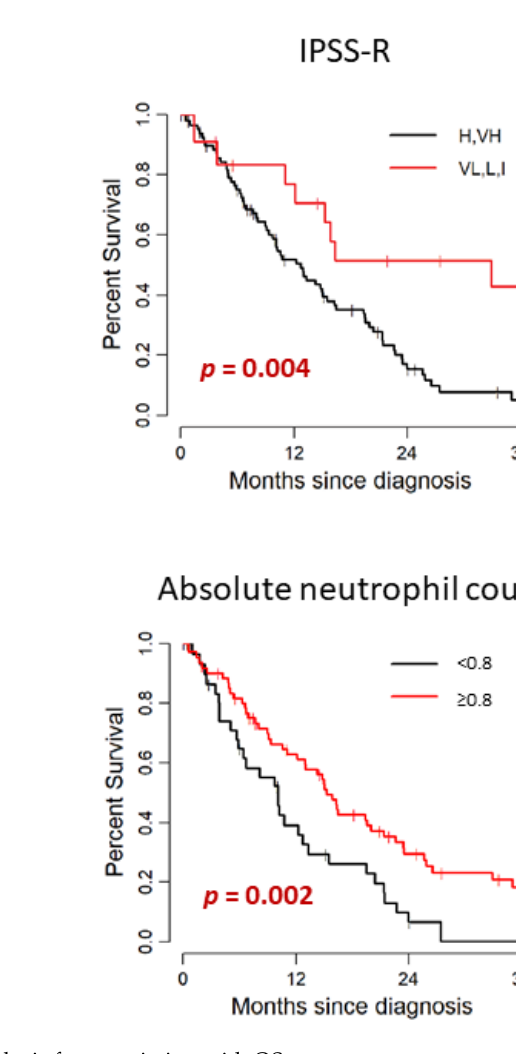
Figure 3. Univariate analysis for association with OS .